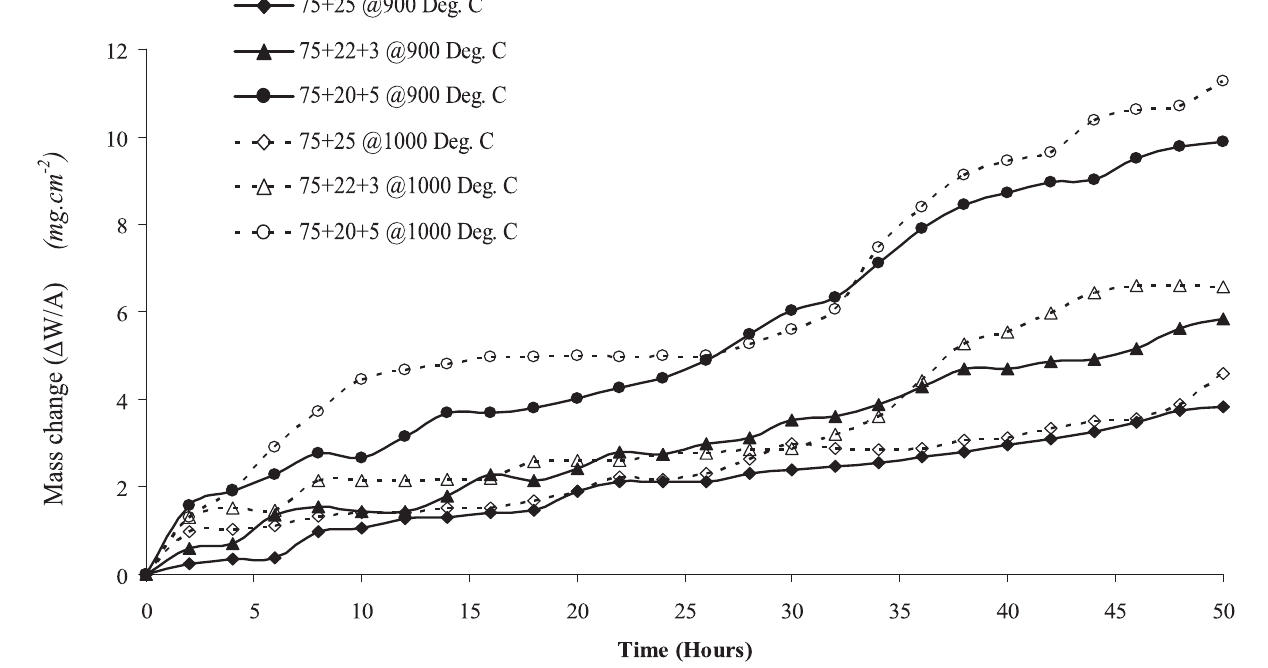
Fig. 1: Mass change in cyclic hot corrosion with respect to exposed time